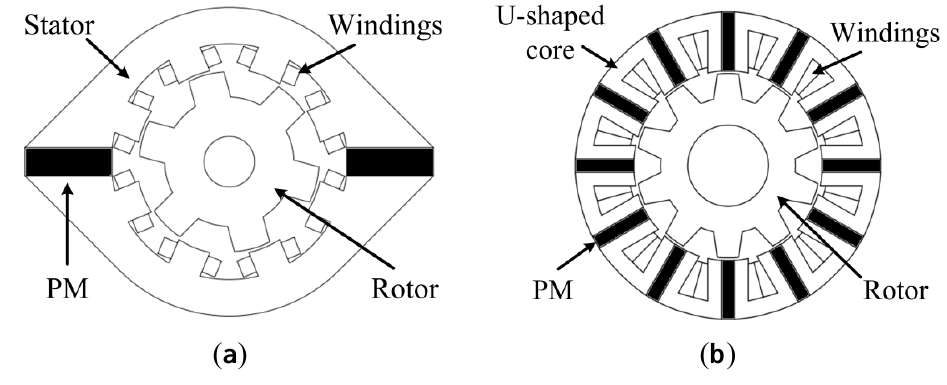
Figure 4. Two representative stator-permanent magnet (PM) motor topologies. ( a ) Doubly-salient PM motor (DSPM); ( b ) Flux switching PM motor